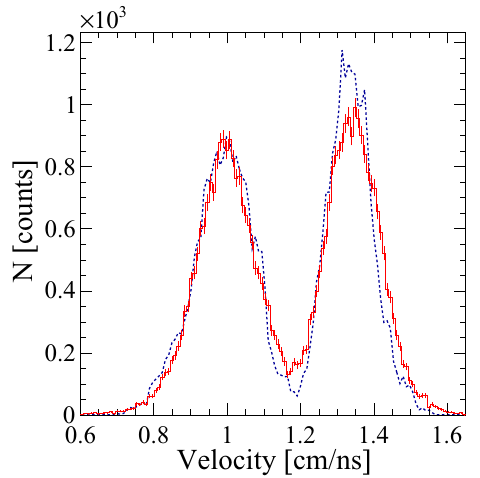
Figure 3. Distributions of velocity of fragments issued from spontaneous fission of a 252 Cf source. The red line is the data measured with the FALSTAFF setup while the blue line is the result of a GEANT4 simulation of the setup using GEF.